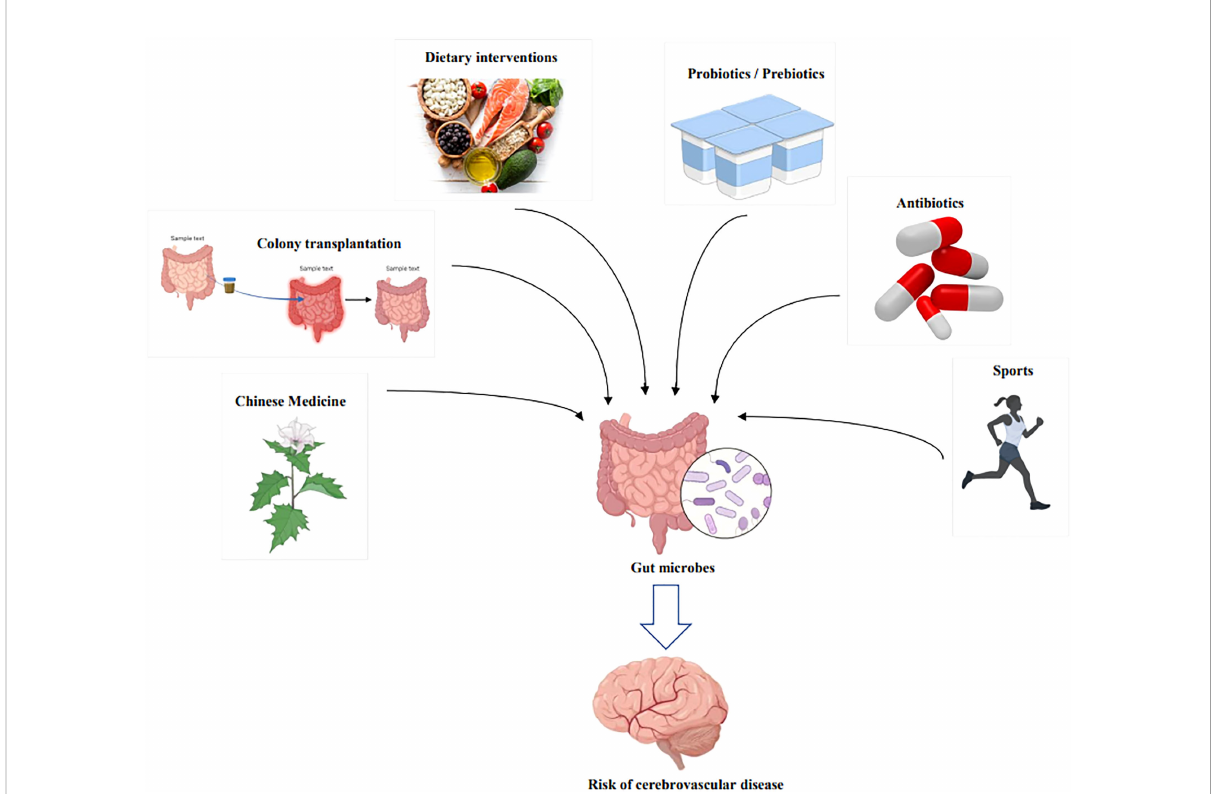
FIGURE 5 Therapeutic modalities for modulating the risk of cerebrovascular disease through intervention with gut microbes. By Figdraw and